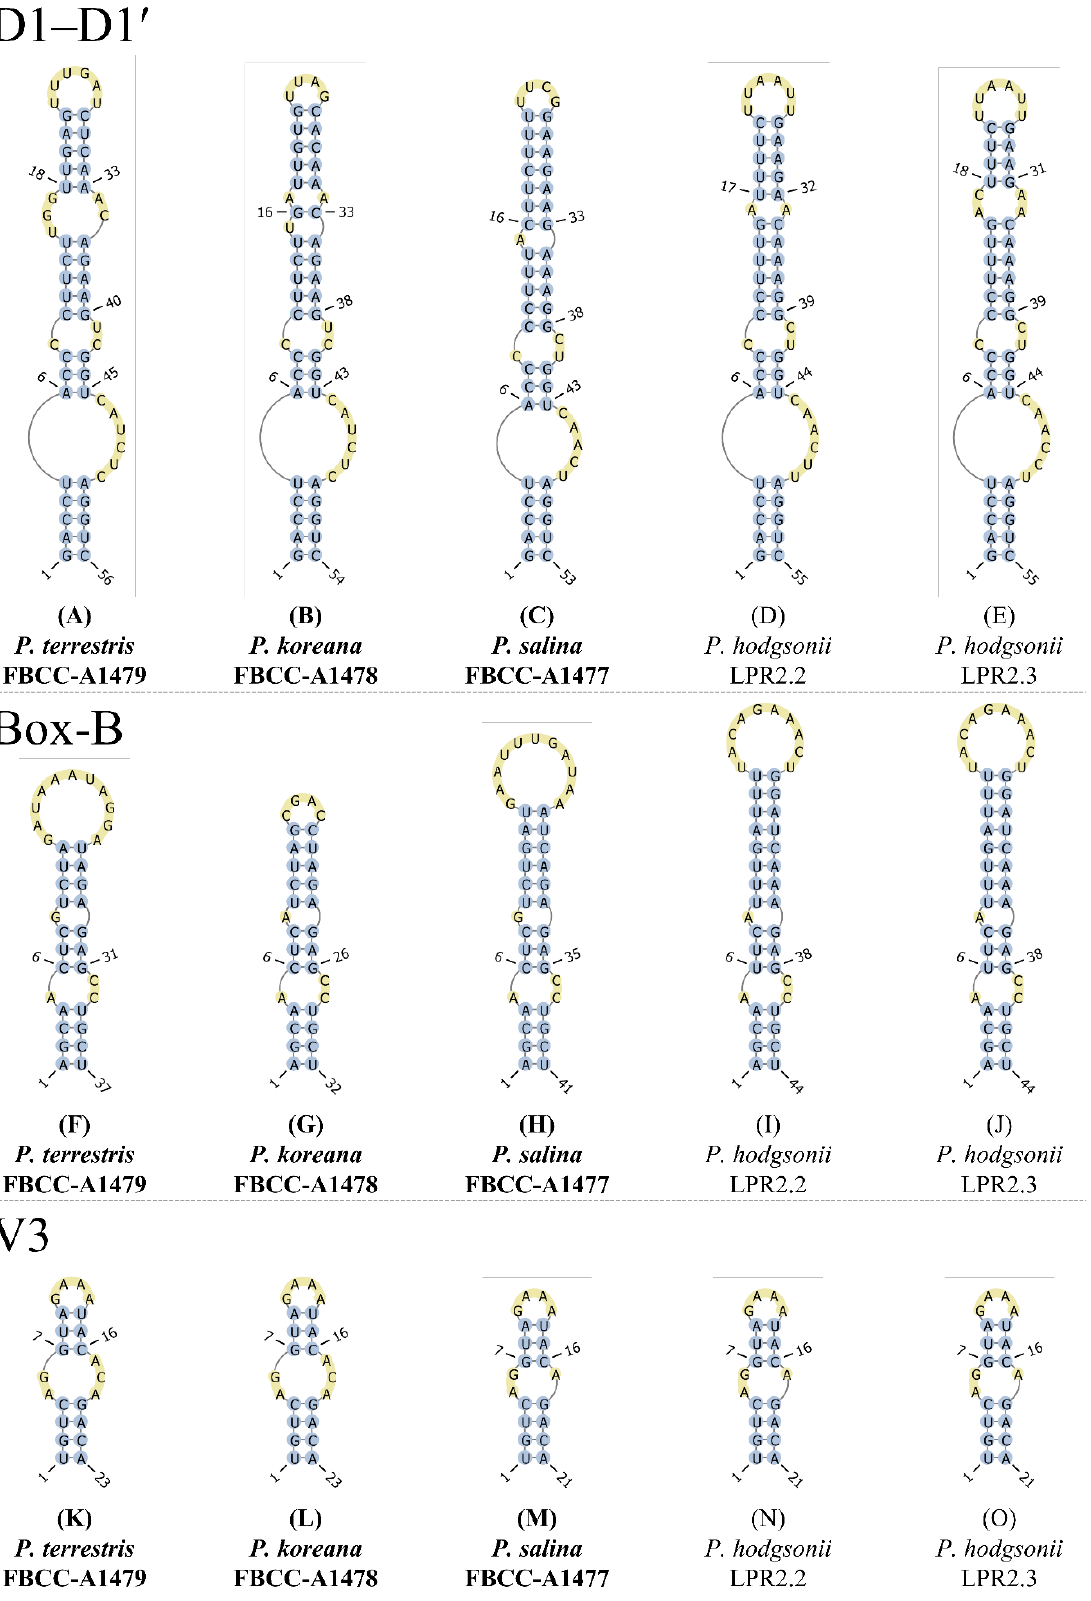
Figure 9. Secondary structures for the D1–D1’, Box-B, and V3 in conserved regions of the 16S–23S ITS. ( A , F , K ) Plectolyngbya terrestris , ( B , G , L ) P. koreana , ( C , H , M ) P. Salina , and ( D , E , I , J , N , O ) P. hodgsonii.